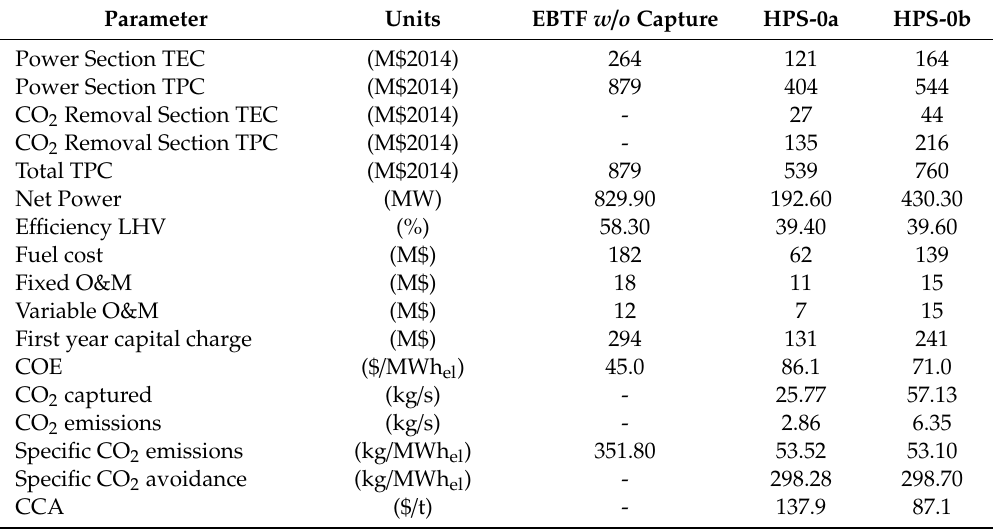
Table 19. Economic evaluation of HPS